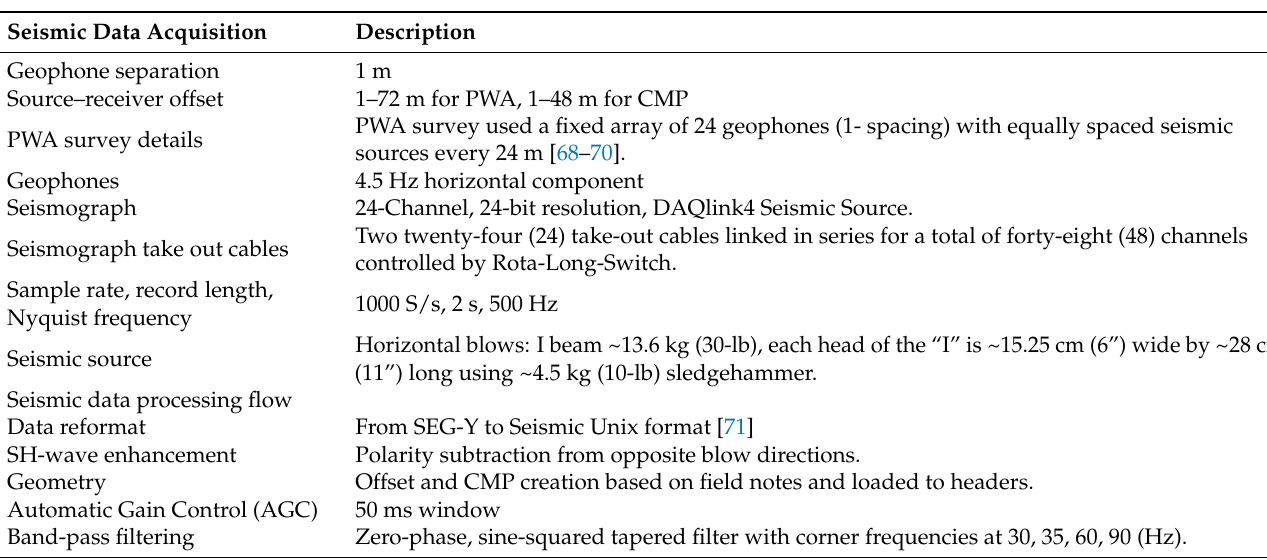
Table 1. Equipment, their accuracy, and seismic algorithms used to collect and display the seismic